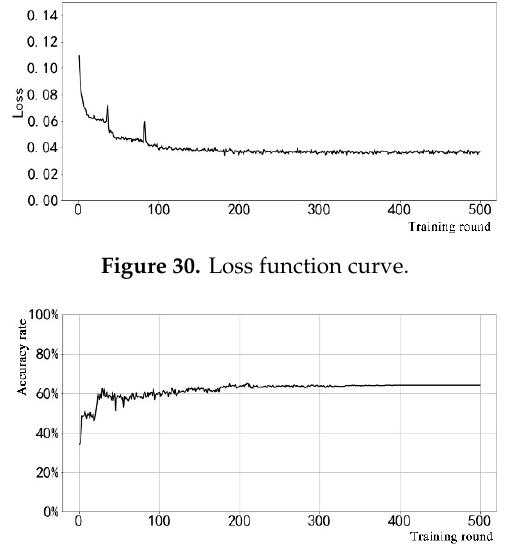
Figure 31. Prediction accuracy curve of the layer thickness.